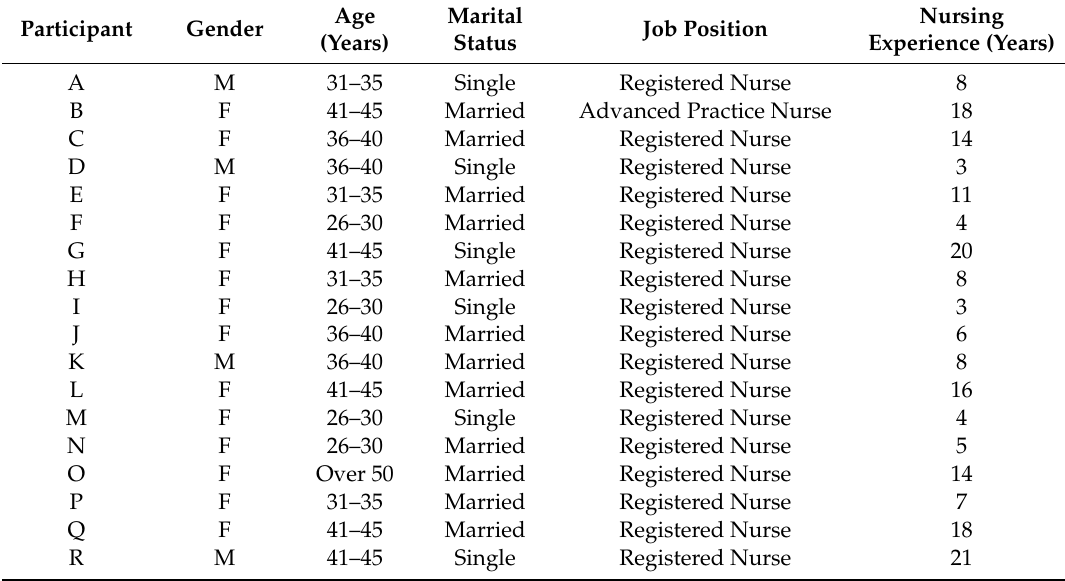
Table 1. Demographic information of participants ( n =